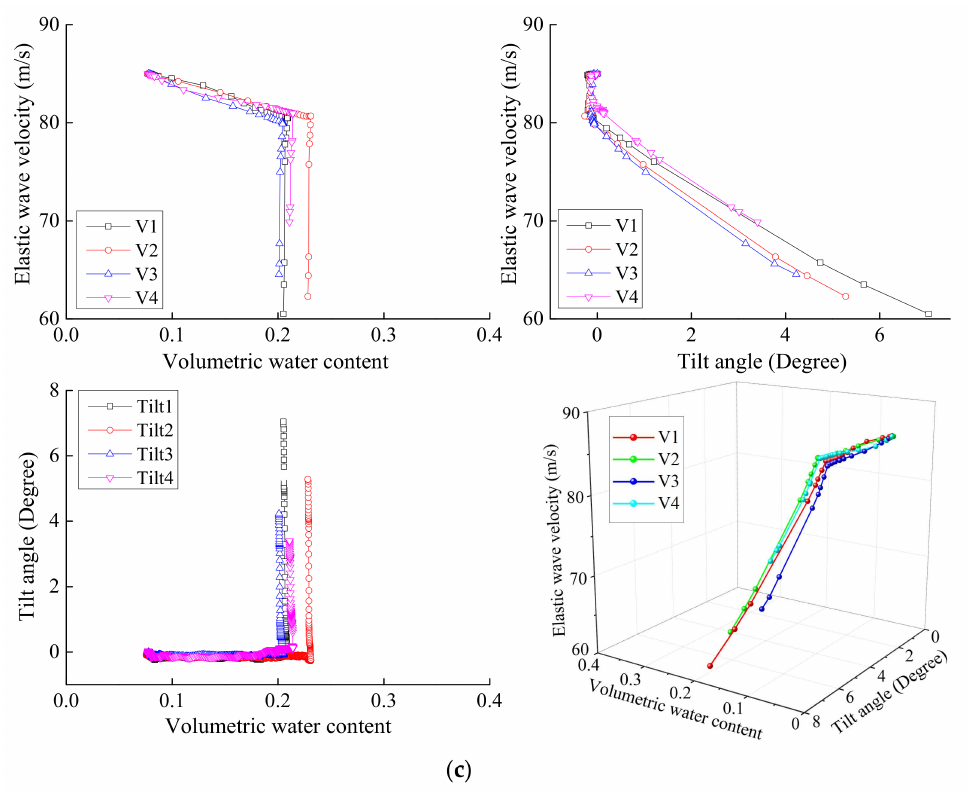
Figure 12. Relationship between elastic wave velocity against volumetric water content and tilt angle by varied model tests with surface layer thickness of ( a ) 5 cm, ( b ) 10 cm and ( c ) 15